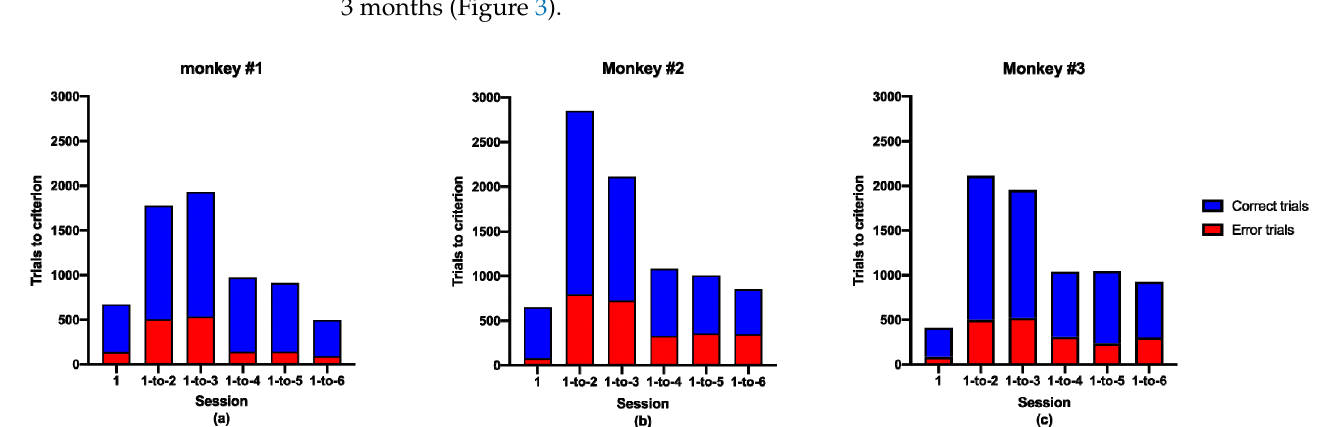
Figure 3. Counting task performance. ( a ) Training records of Monkey #1 in each of the tasks, including the total trials and errors before satisfying the test criterion; ( b ) Training records of Monkey #2; ( c ) Training records of Monkey #3.